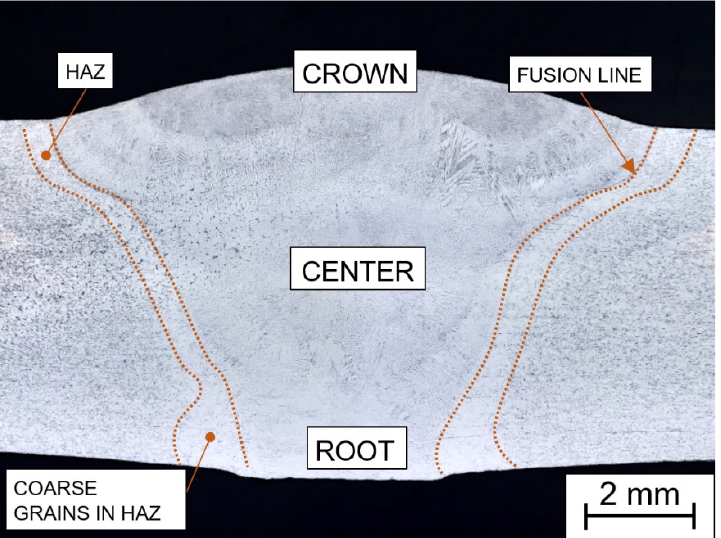
Figure 3. Macrograph of the homogeneous weld, without heat treatment, immersion etched in